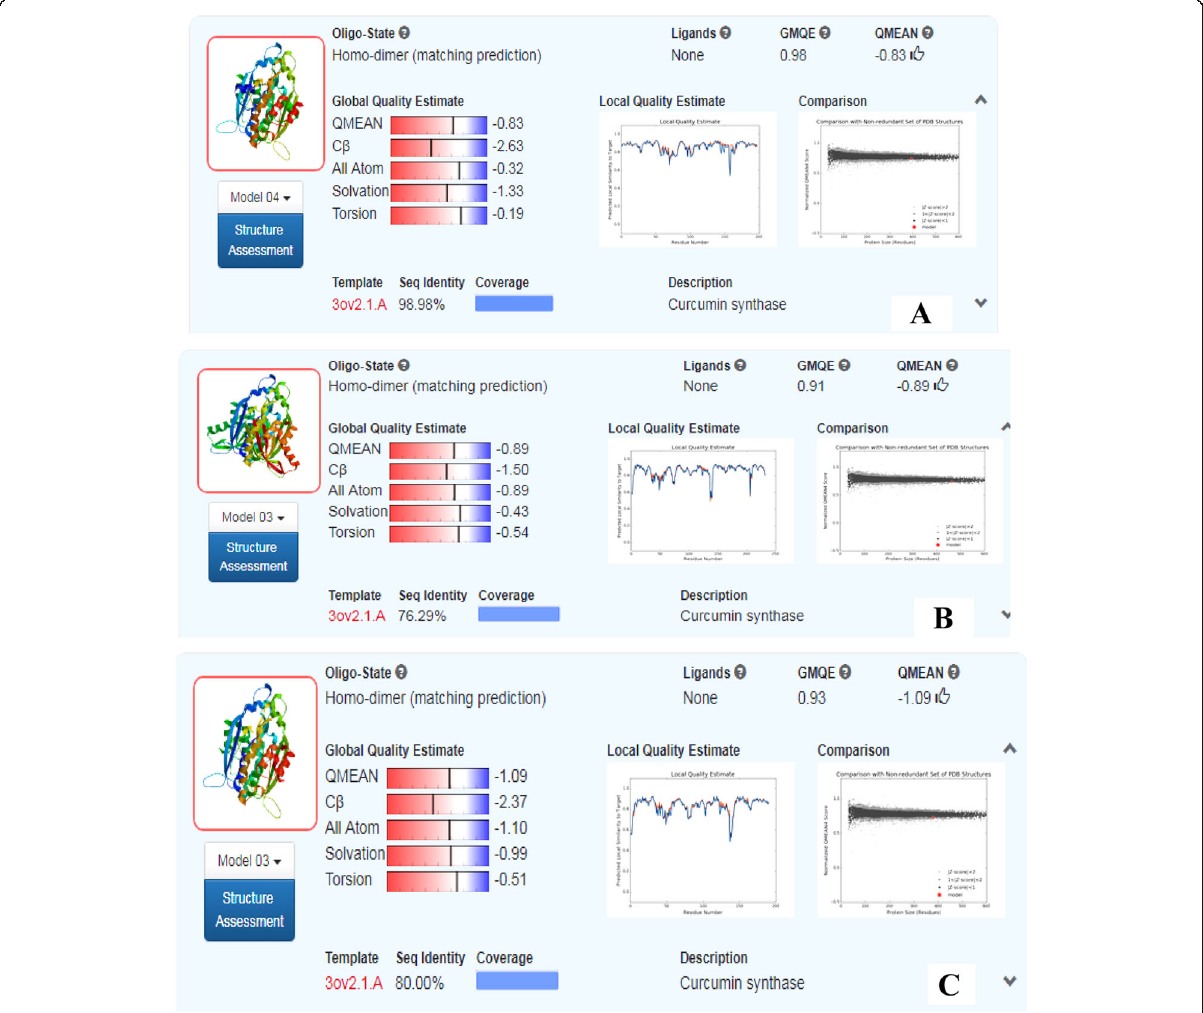
Fig. 6 Quality estimation (GMQE, QMEAN, local quality estimate, and comparison plot) of a CURS1, b CURS2, and c CURS3